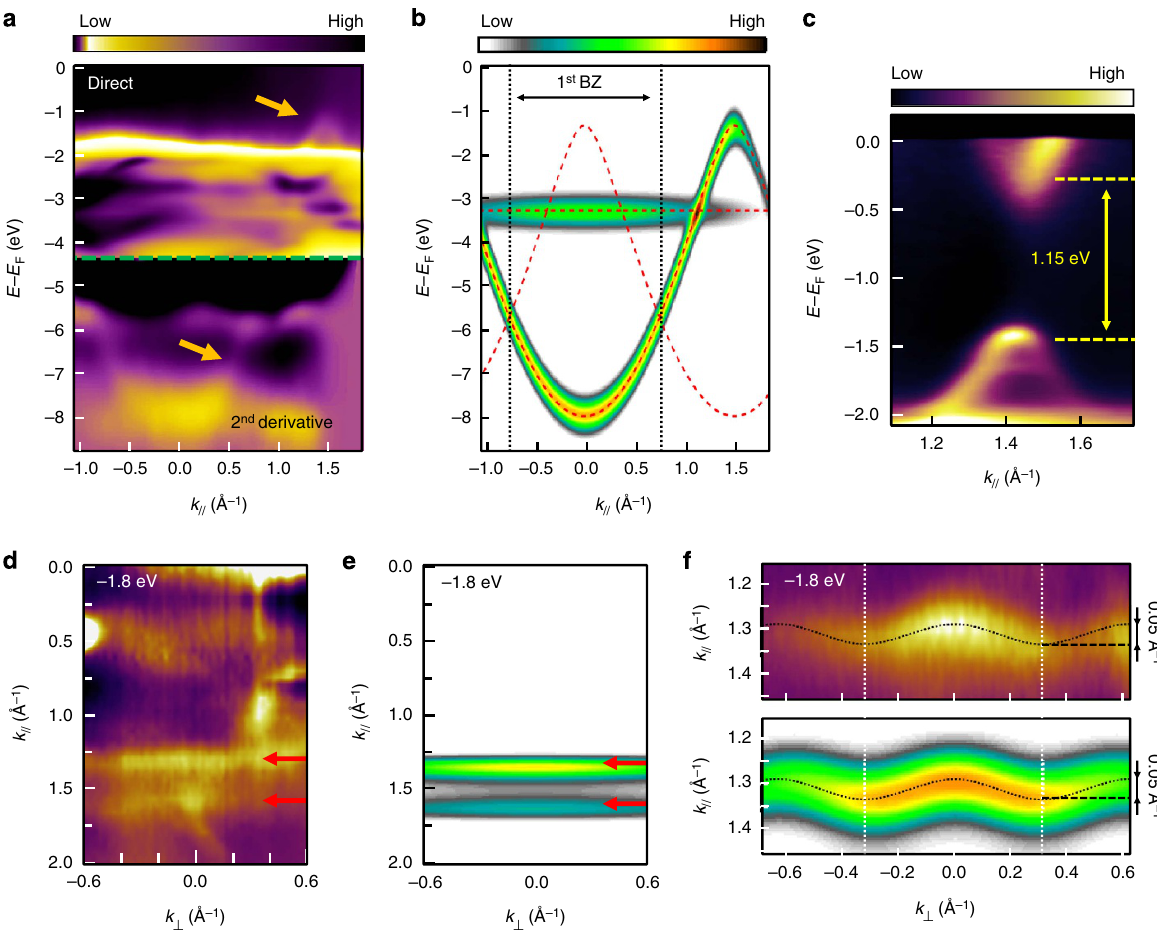
Figure 3 | Angle-resolved photoelectron spectroscopy measurements. ( a ) ARPES intensity map measured along the o 1–12 4 direction, parallel to the polymers chains for 1ML-PPP/Cu(110). The bottom part is displayed in second derivative. Arrows indicate bands due to the presence of polymers. ( b ) Tight-binding modelling of the band structure of the N ¼ 20 PPP polymer using b ¼ (cid:2) 3.5eV. ( c ) High-resolution ARPES intensity map recorded close to the Fermi level showing the HOMO–LUMO bandgap. Measurements ( d ) and tight-binding modelling ( e ) of the ARPES constant energy map at (cid:2) 1.8eV. ( f ) Zoom on the measured (top) and calculated (bottom) ARPES constant energy maps. The transverse resonance integral used in the calculations is b 0 ¼ (cid:2)